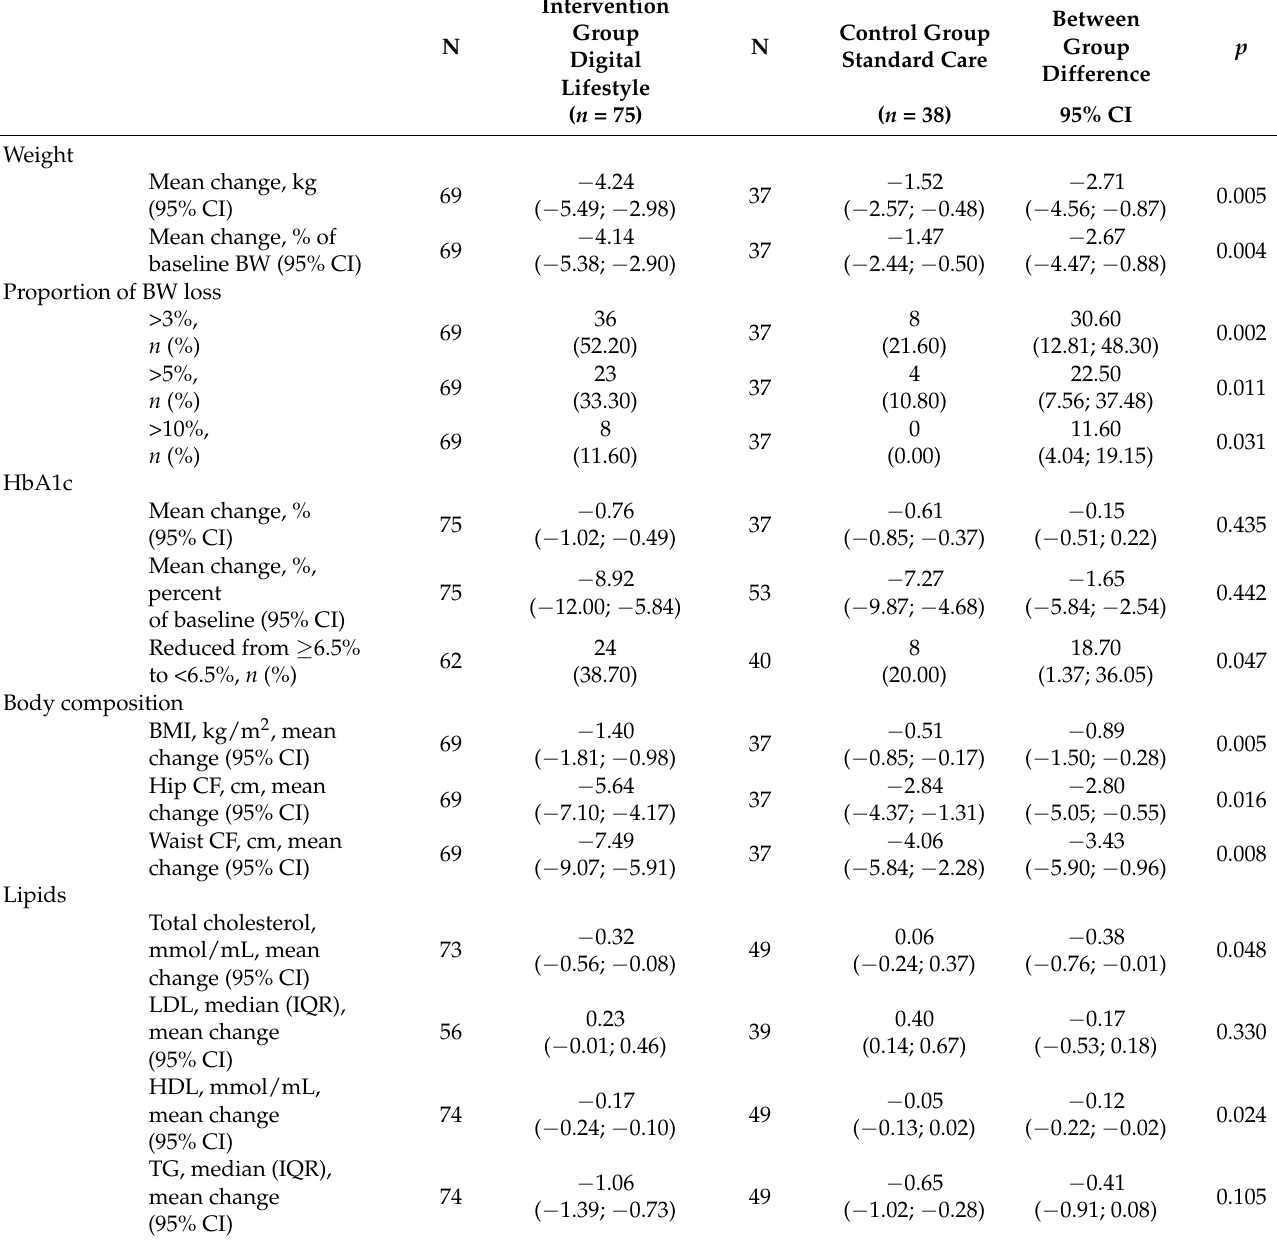
Table 4. Between-group differences in changes from baseline to six